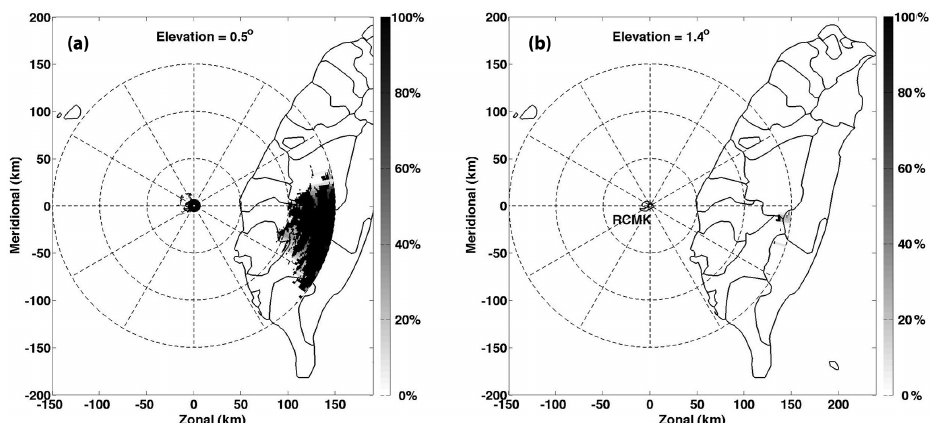
Figure 2. Blockage maps of RCMK from the first two EAs (0.5 and 1.4 ◦ ). The grayscale indicates the blockage percentages.